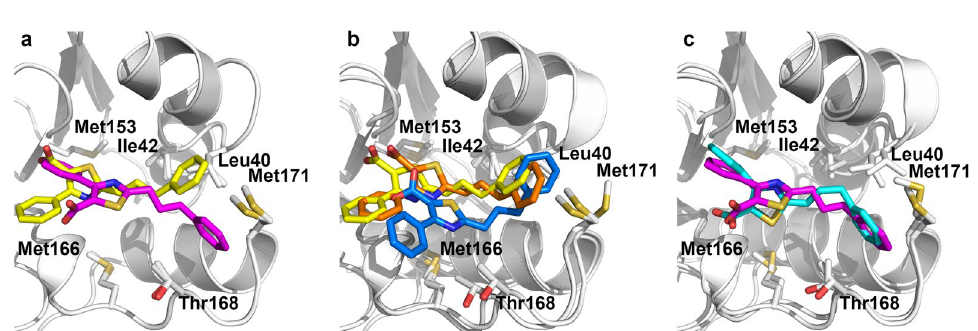
Figure 4. Ec DsbA – phenylthiazole 1 complex structures derived by N MR 2 , X-ray crystallography and classical NMR structure calculation. ( a ) Overlay of best and second-best N MR 2 models depicted in yellow and magenta, respectively. ( b ) Comparison of best N MR 2 model against classical CYANA and crystal structures, depicted in yellow, orange, and blue respectively. ( c ) Comparison of the second-best pose of N MR 2 against the best HADDOCK model, depicted in cyan. All models were globally aligned to the crystal structure in PyMOL. Only the binding site of all models is shown for